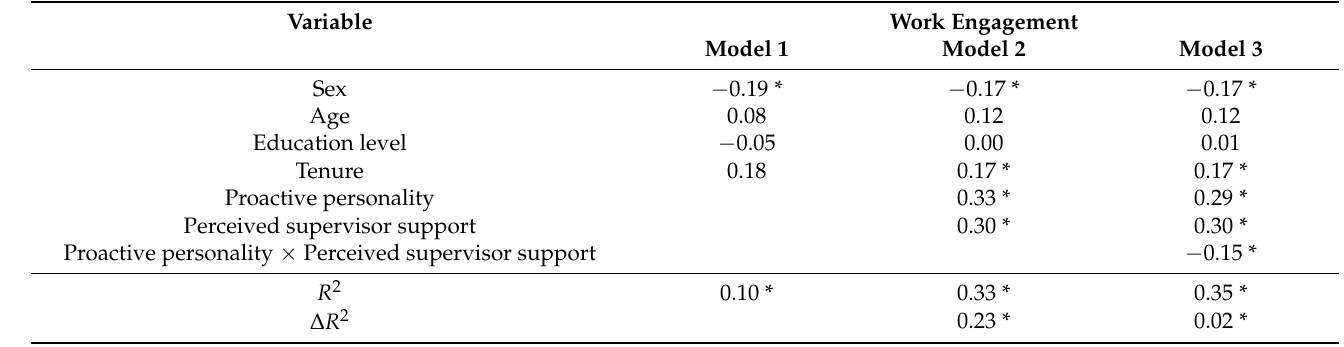
Table 3. Hierarchical regression analysis of study variables and their interaction with work engage-